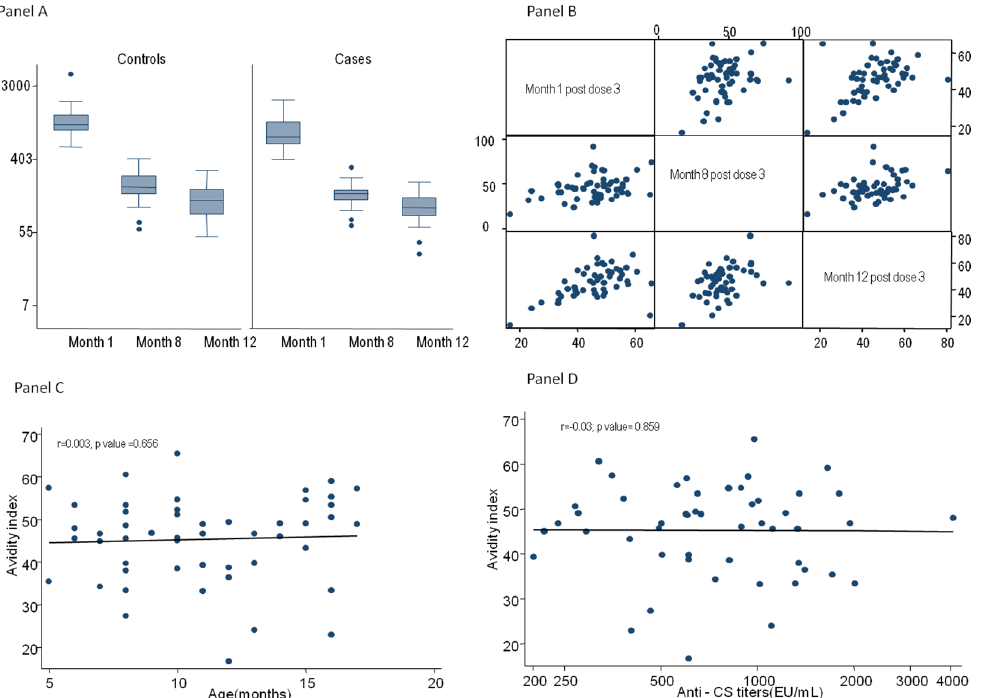
Fig. 1. Panel A: Anti-CS titers in cases, controls and 19 protected children with low anti-CS antibodies titer and high malaria exposure index during 15 months of follow-up. Panel B: Matrix diagram showing correlation between antibody avidity measured at three time points during the follow up. Significant correlation observed between AI at 1 month post-dose 3 and at , 8 months post-dose 3 (r 5 0.33, p value 5 0.0111) and at 1 month and 12 months post-dose 3 (r 5 0.48, p value 5 0.0002). Panel C: Correlation between anti-CS antibody avidity at 1 month post dose 3 and age (r 5 0.003, p value 5 0.656) Panel D: Correlation between anti-CS antibody avidity and anti-CS antibody titers at 1 month post dose 3 (r 5 –0.03; p value 5 0.859).